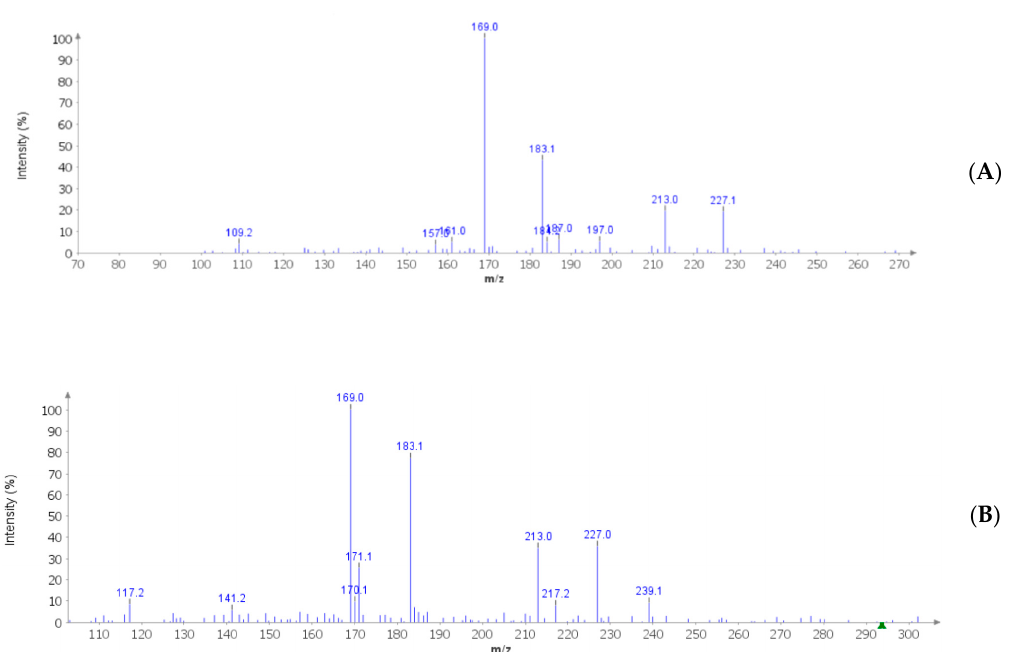
Figure 1. Optimization of C. minima extraction with water and hydroalcoholic solution following sonication- and Soxtec-assisted extractive methods. ( A ) Dry extract yield; ( B ) total phenol yield; ( C ) total flavonoid yield.